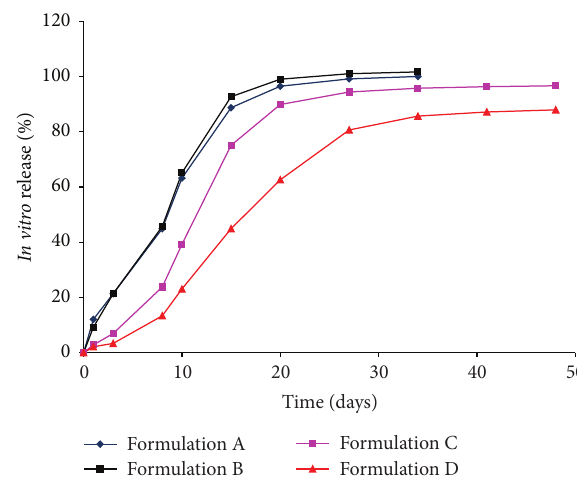
Figure 1: In vitro release of Olanzapine PLGA